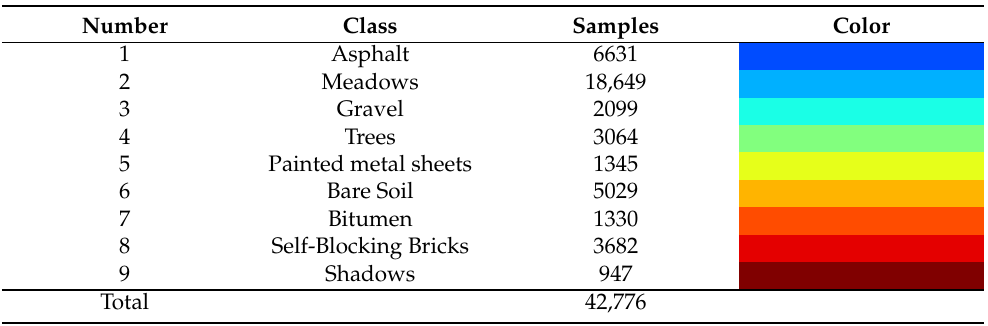
Table 3. The information of each class in